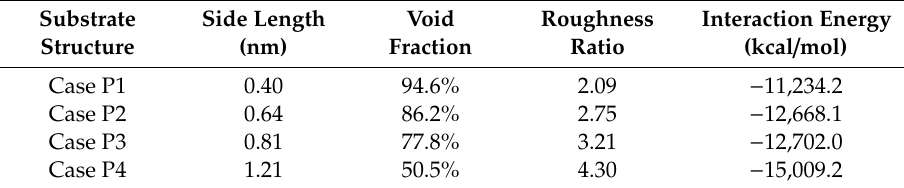
Table 3. Side length, void fraction, roughness ratio and interaction energy at 6.5 ns with di ff erent substrate structures on Al